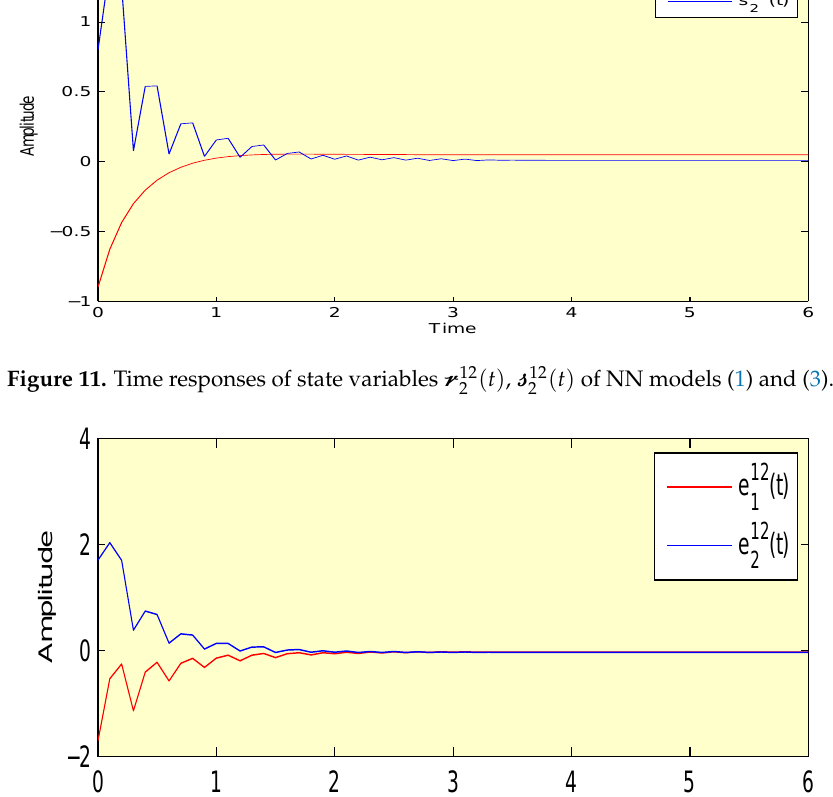
Figure 12. Synchronization curves of state variables (cid:101) 12 troller